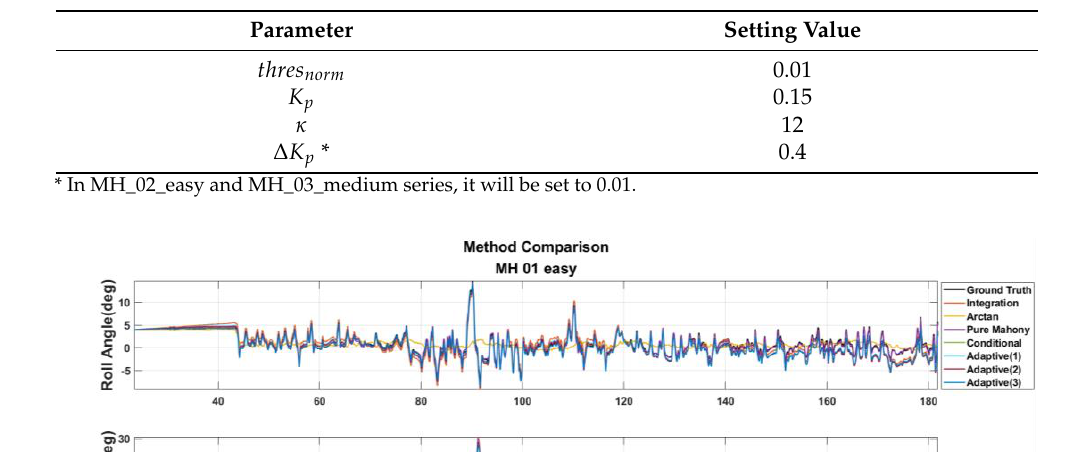
Table 3. Parameter setting for the proposed online adaptive p K tuning algorithm.